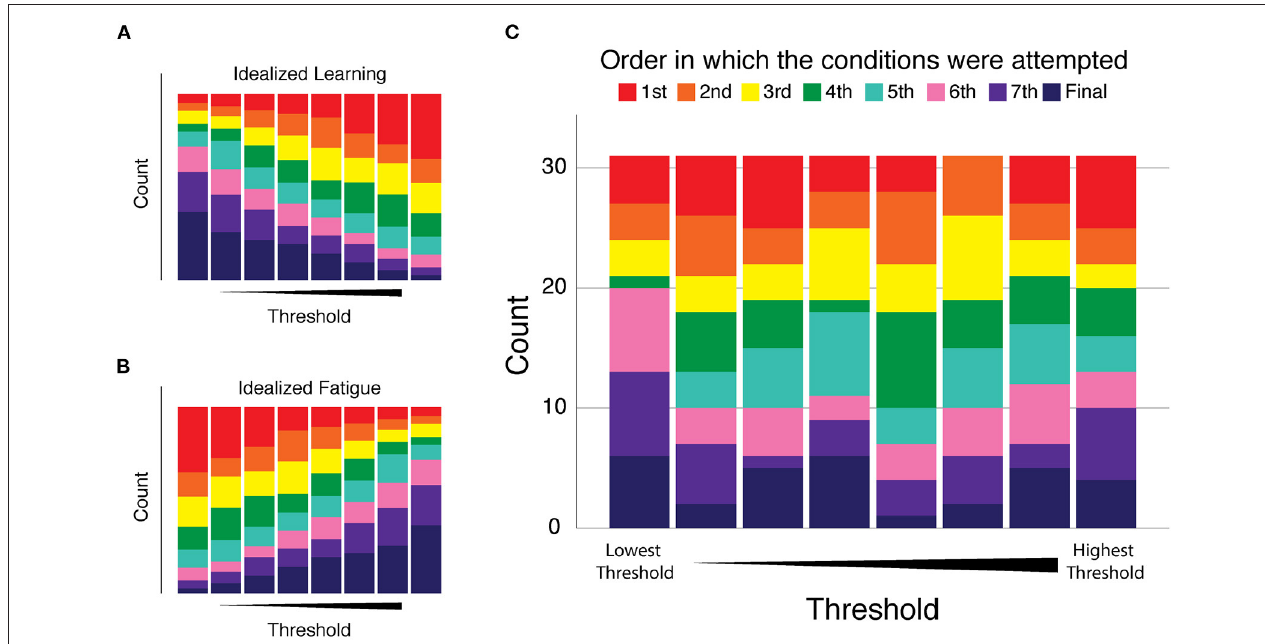
FIGURE 4 | Analysis of performance changes over the course of the eight 2AFC experiments of Experiment 1. Condition Order: the order in which the conditions were performed were numbered and color coded from one (red) to eight (dark blue). Threshold Order: the ranked magnitude of each participant’s discrimination thresholds from smallest (best) to largest (worst). Each plot presents the number of times (count) each condition resulted in the smallest threshold (left-most stacked bar) on up to the largest threshold (right-most stacked bar). (A) Idealized “learning” condition modeled as a consistent trend of improvement with practice as the experiments progress. (B) Idealized “fatigue” modeled as a consistent trend of decreasing performance as the experiments progressed. (C) Cohort results: we observed no consistent trend of performance change as a function of condition order. The disorganized pattern of bar sizes of all colors indicates that smaller and larger thresholds were equally likely to occur at any time during the experimental session.